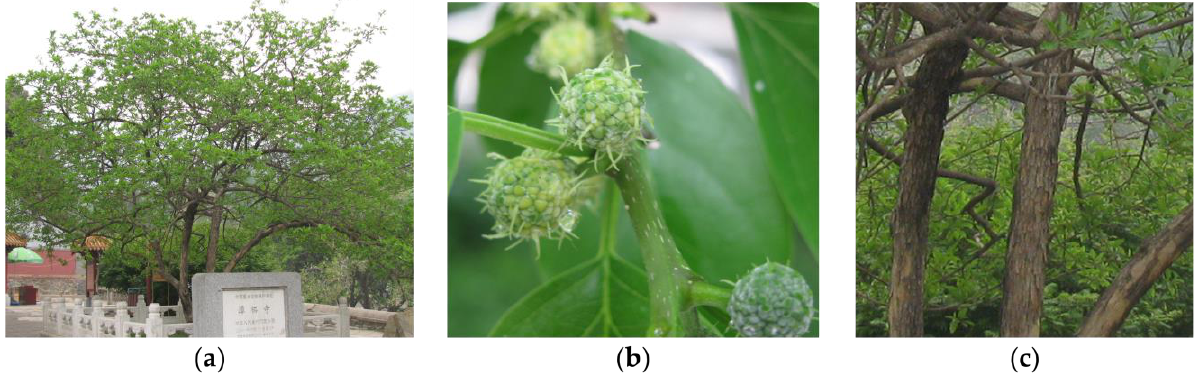
Figure 1. Display of Cudrania tricuspidata : ( a ) the tree as a whole; ( b ) the fruit of the tree; ( c ) the trunk of the tree.